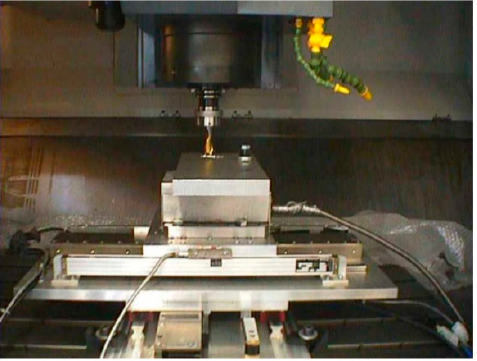
Figure 28. The milling machine tool with a linear motor feed system. Reprinted with permission from ref. [124]. Copyright 2005 Elsevier Ltd.